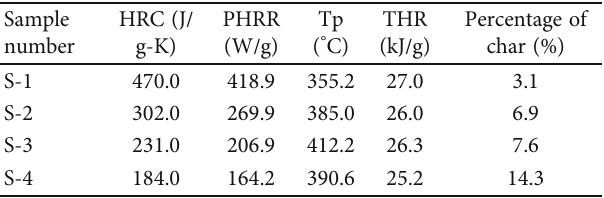
Figure 8: The heat release rate curves versus temperature of WPU and WPU Table 3: Microscale combustion data of the WPU and WPU composite samples.